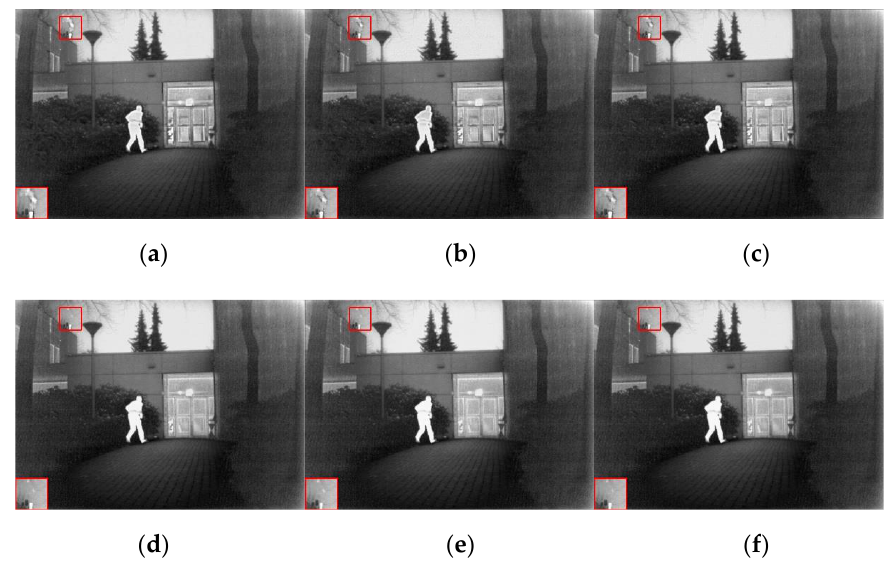
Figure 7. Experimental results of different loss function parameters, ( a ) λ = 0.1; ( b ) λ = 0.5; ( c ) λ = 1; ( d ) λ = 10; ( e ) λ = 100; ( f ) λ = 1000.